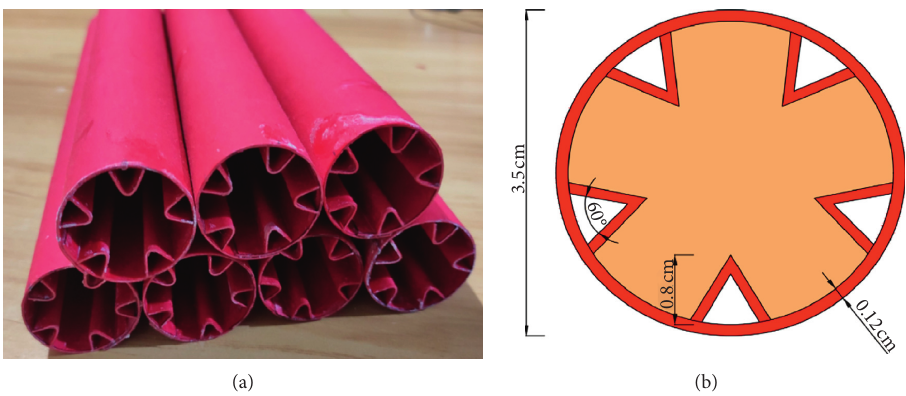
Figure 6: Multidirectional shaped charge pipe: (a) product; (b) section size.